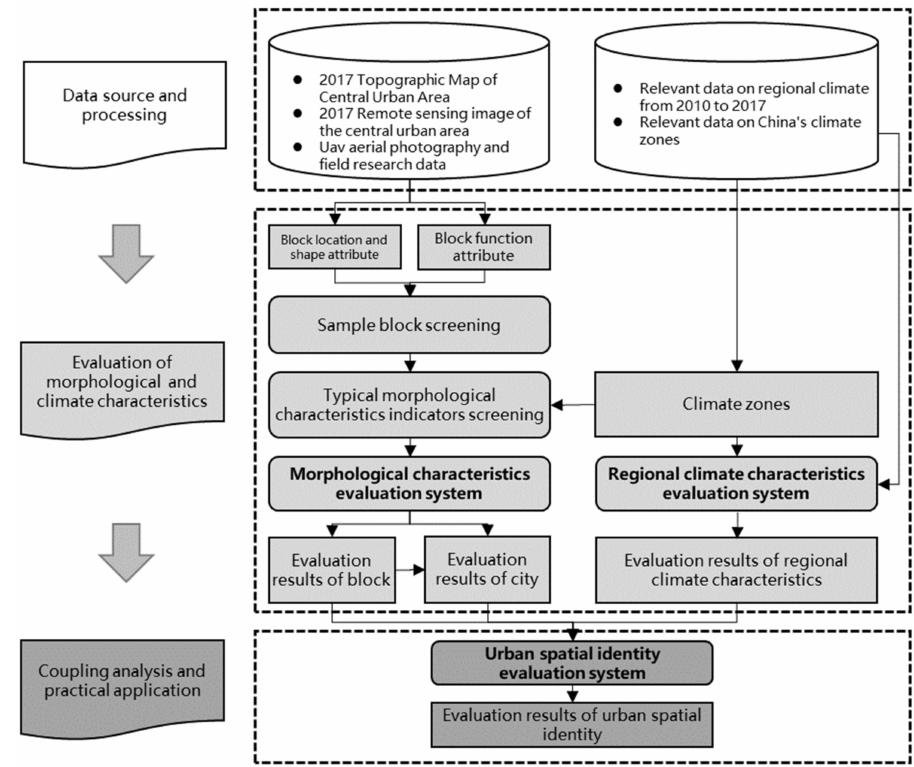
Figure 4. The framework for evaluating the spatial